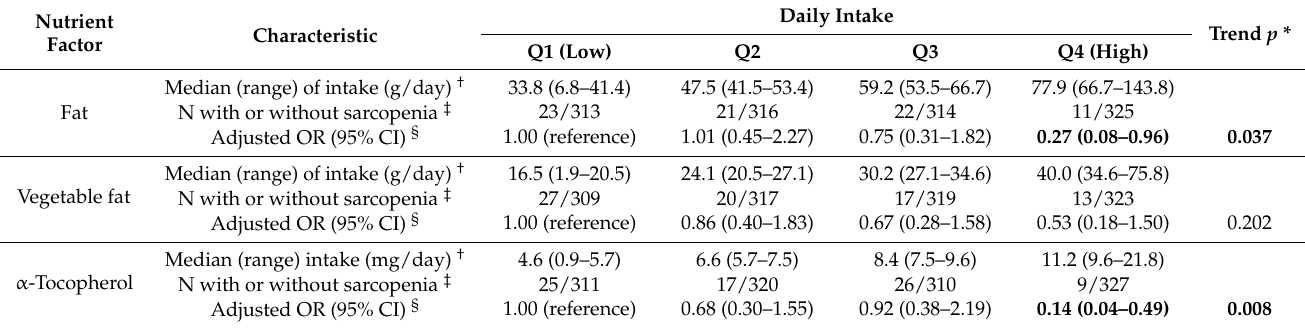
Table 3. Prevalence of sarcopenia according to the quantile of the intakes of vitamin E and